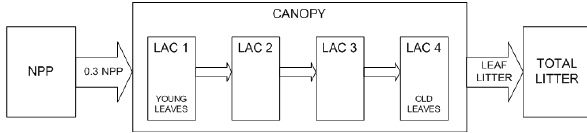
Fig. 2. Schematic representation of the new leaf turnover scheme implemented in ORCHIDEE-TrBE. The amount of carbon allo- Figure 2. Schematic representation of the new leaf turnover scheme implemented in cated to youngest leaves equals the amount of carbon lost by lit- ORCHIDEE-TrBE. The amount of carbon allocated to youngest leaves equals the amount of terfall of oldest leaves. The canopy leaf biomass conversion of the carbon lost by litterfall of oldest leaves. The canopy leaf biomass conversion of the four four different leaf age classes (LAC) with biomass being passed different leaf age classes (LAC) with biomass being passed from younger LAC to older LAC from younger LAC to older LAC is as in the standard ORCHIDEE is as in the standard ORCHIDEE version.